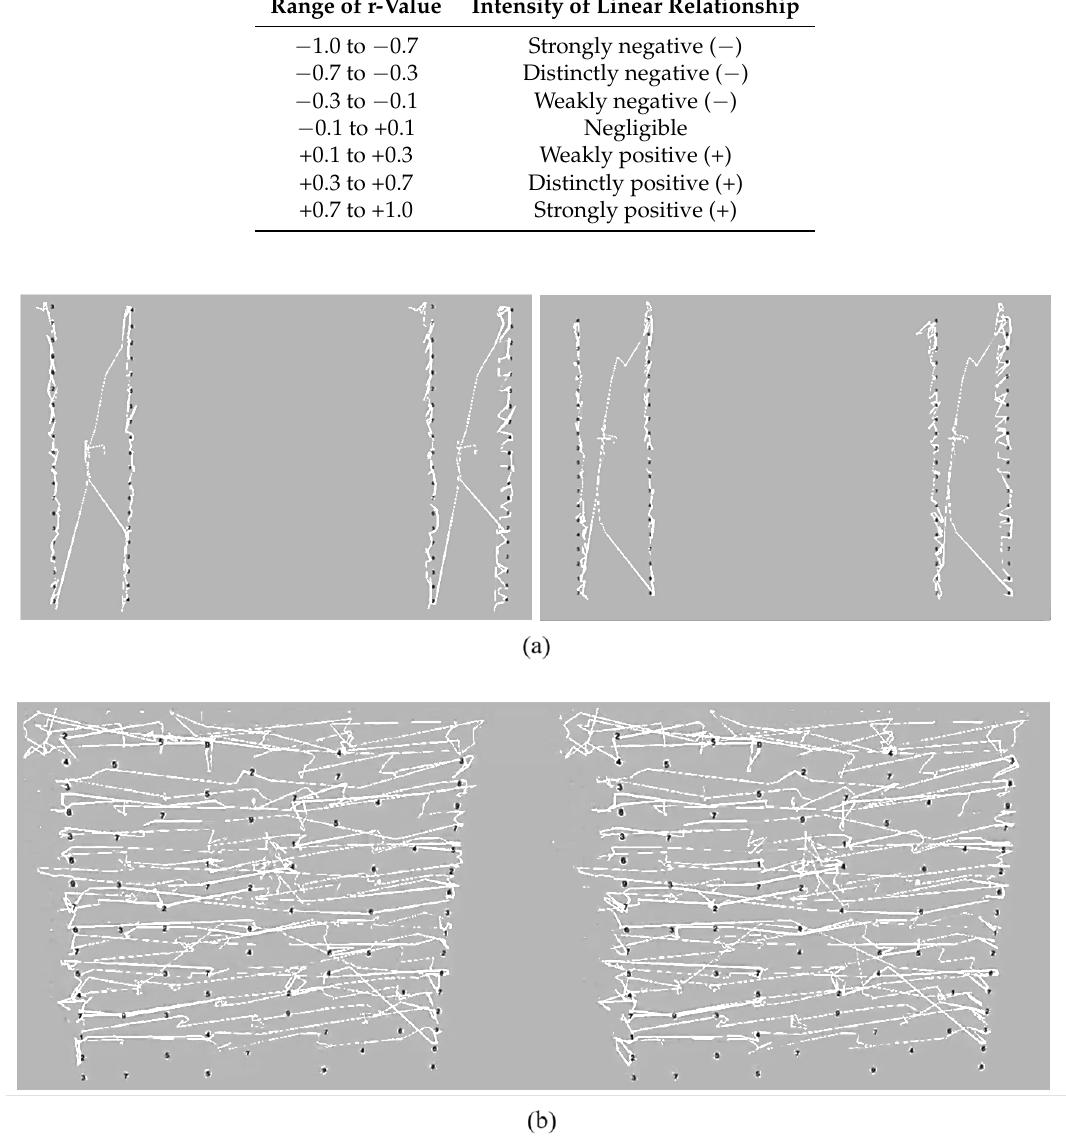
Figure 3. The eye movement-trajectory of the DEM test performed with the proposed method: ( a ) Test A and B; ( b ) Test